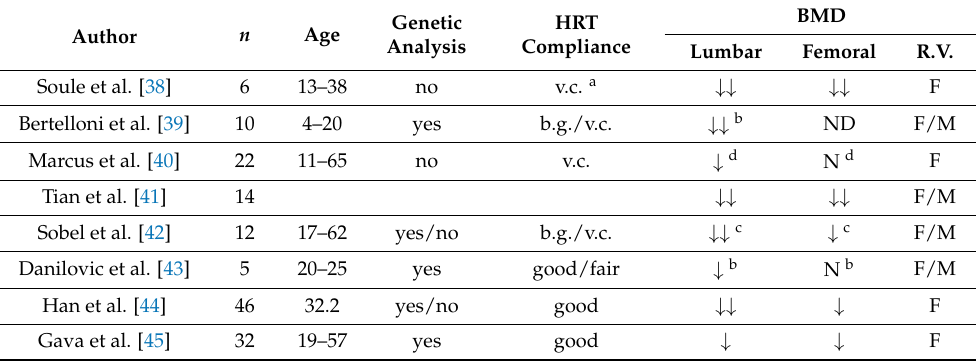
Table 2. Some mechanisms involved in impaired bone health in females with CAIS [30–36]. Factor(s) Mechanism(s) Complete AR resistance Abnormal activity of osteoblasts and osteocytes. Inadequate hormonal substitutive therapy. Absence of testicular INSL-3 (reduced bone mass through Iatrogenic dysregulation of osteoblastic differentiation, deposition of the bone hypergonadotropic matrix and osteoclastogenesis; altered functioning of the hypogonadism musculo-skeletal unit in postnatal life). High FSH levels (greater bone resorption by osteoclasts due to the activation of the FSH receptor *) Age at gonadectomy (before or after achievement of peak bone mass). Type, doses, compliance and duration of HRT. Others Unhealthy eating, low calcium intake, reduced physical activity, inadequate muscle mass, smoking and low vitamin D. Aging.